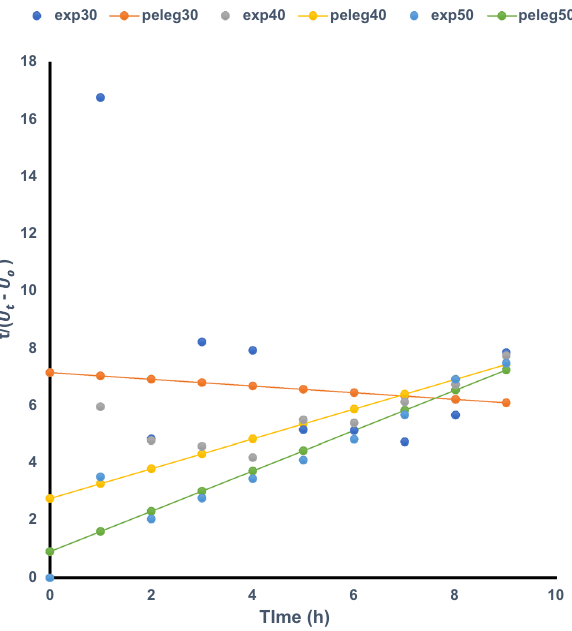
Figure 3. Experimental and Peleg (predicted) water uptake of Mucuna veracruz at different temperatures. SPSS software url: ibm.com/products/spss-statistics. Data fit software url: https ://datafi t.softw are.infor